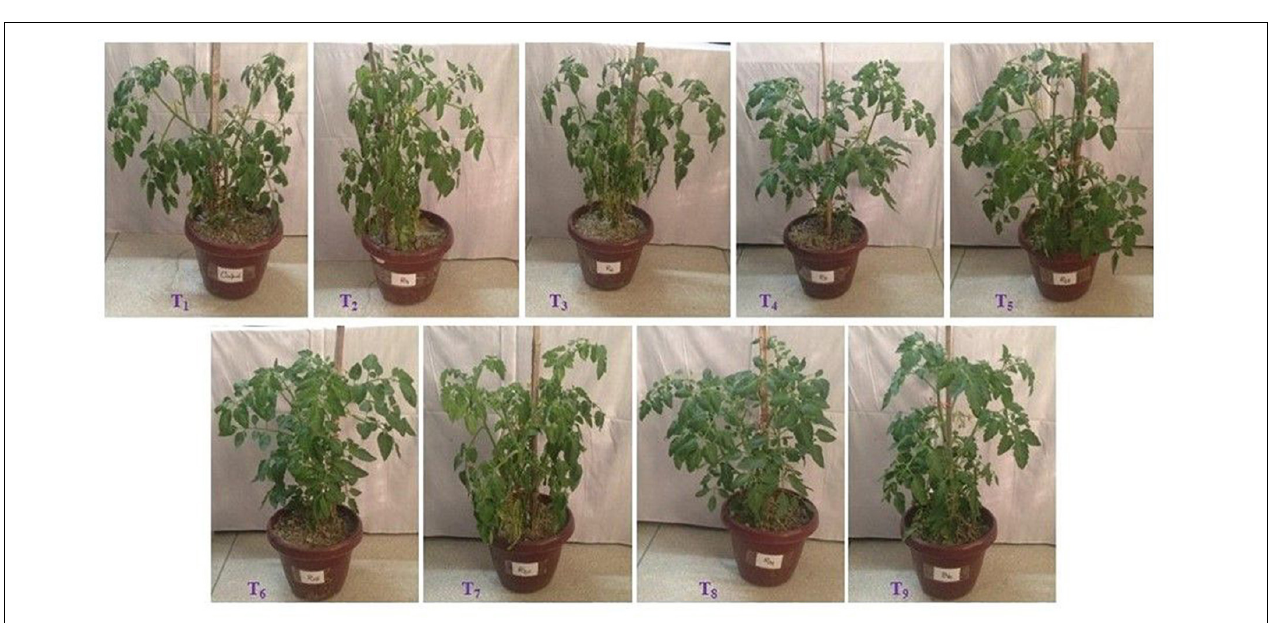
FIGURE 9 | Effect of bacterial inoculation on growth of tomato plants under water deficit stressed conditions. Photographs were taken on 12th day of water stress. T 1 = Without bacterial inoculation, T 2 , T 3 , T 4 , T 5 , T 6 , T 7 , T 8 , and T 9 = Tomato plants inoculated with P. azotoformans ESR4, P. poae ESR6, P. gessardii ESR9, P. cedrina ESR12, P. chlororaphis ESR15, S. maltophilia ESR20, P. veronii ESR21, and B. aryabhattai ESB6,